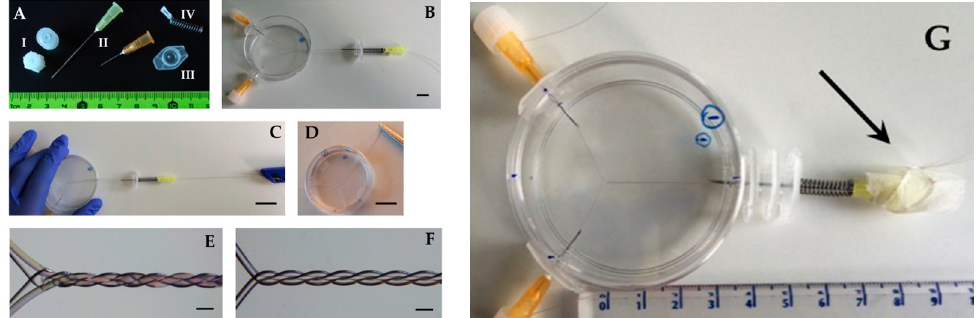
Figure 2. Manufacturing and reproducibility. ( A ) I: Example of caps that were used to fix the threads (see ( B )), II: needles, III: Eppendorf caps that were cut off the tubes and IV: a ballpoint